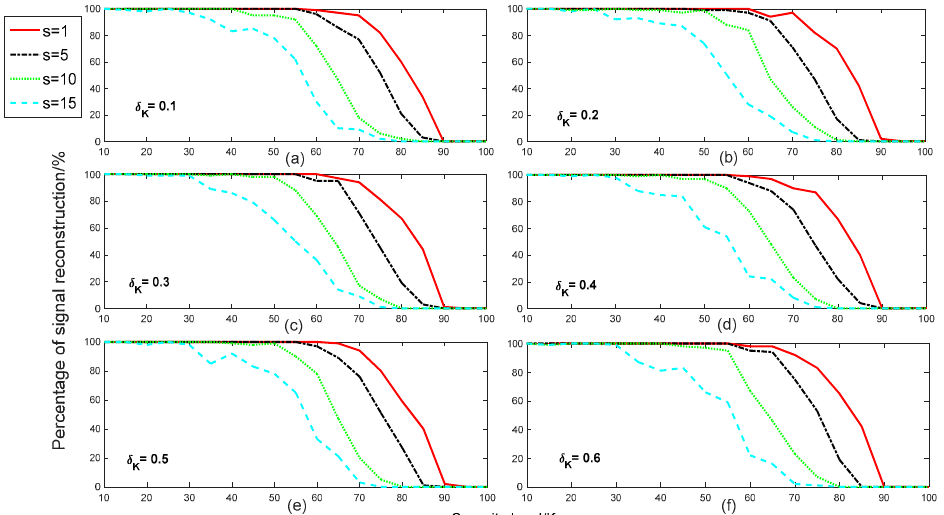
Figure 2. Reconstruction percentage of different step-sizes with different sparsities in different isometry constant conditions ( n = 400, s ∈ [ 1,5,10,15 ] , δ K ∈ [ 0.1,0.2,0.3,0.4,0.5,0.6 ] and m = 170, Gaussian signal).